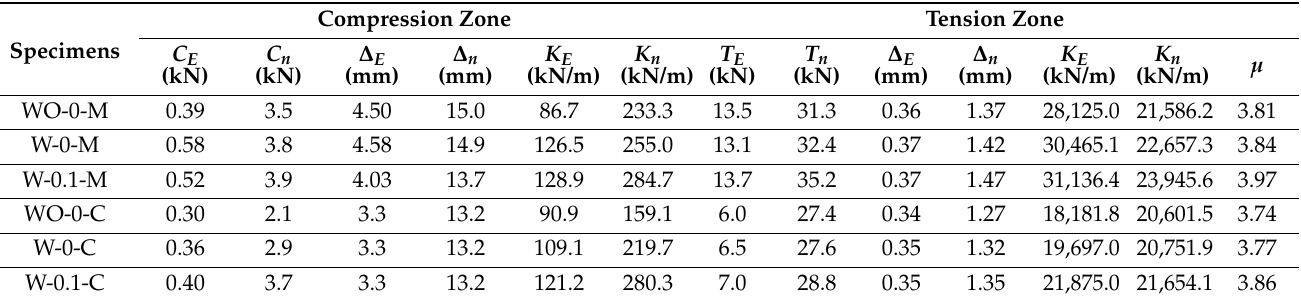
Table 3. Summary of test results subjected to axial load.